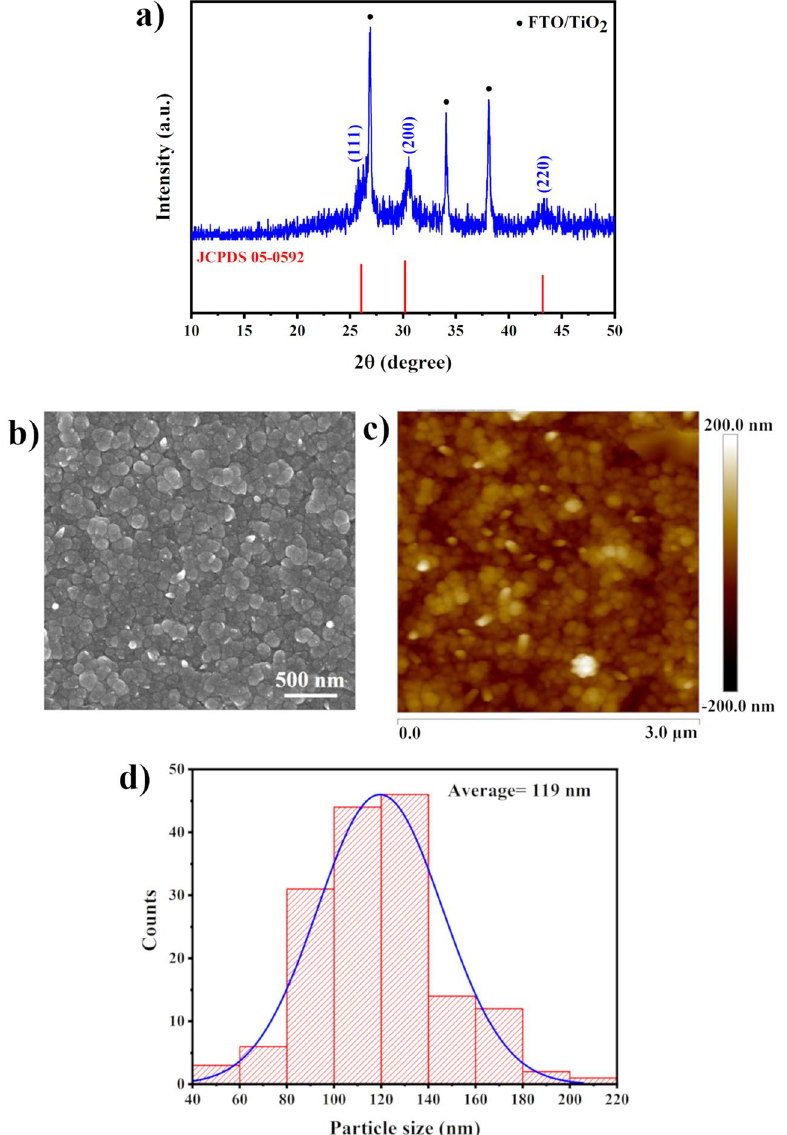
Figure 1. Structural and morphological characterization of chemically deposited PbS film. ( a ) XRD diffraction pattern ( b ) surface SEM image ( c ) AFM image and ( d ) grain size distribution